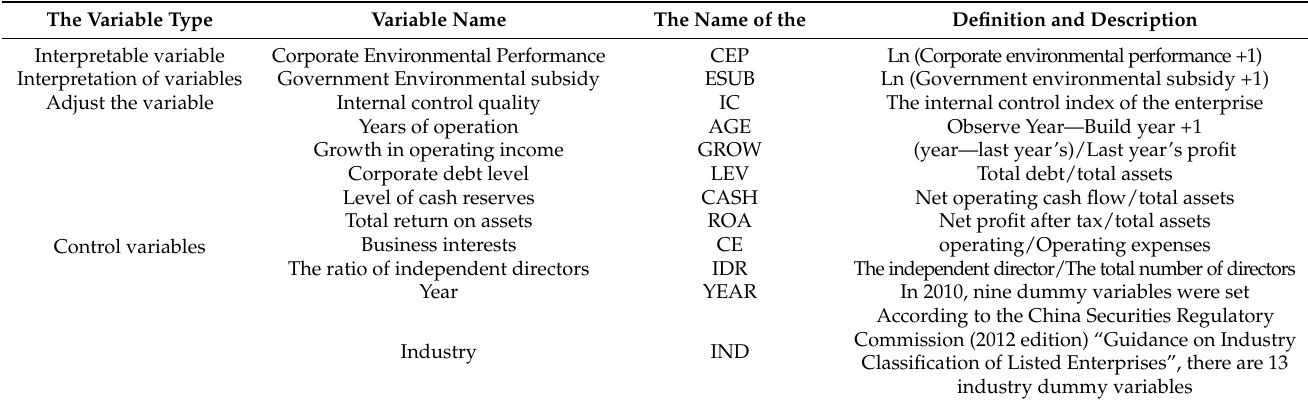
Table 2. Variable definition